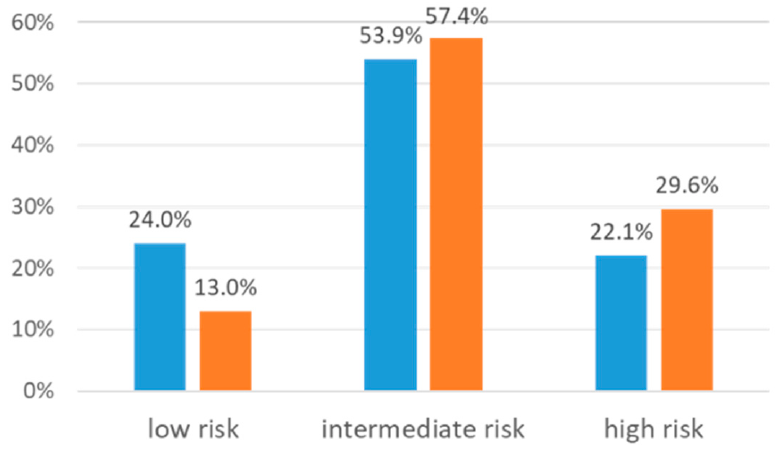
Figure 2. Differences in pharmacogenetic anticoagulant activity risk profiles for no suspected phenprocoumon (blue columns) and suspected phenprocoumon (orange columns), p = 0.052. Low risk was defined as being CYP2C9 NM and VKORC1 NC. Intermediate risk was defined as having either low CYP2C9 activity (intermediate metabolizer (IM) or poor metabolizer (PM)) or low VKORC1 activity (intermediate clotter (IC) or poor clotter (PC)). High-risk patients were those with a low CYP2C9 activity and a low VKORC1 activity.